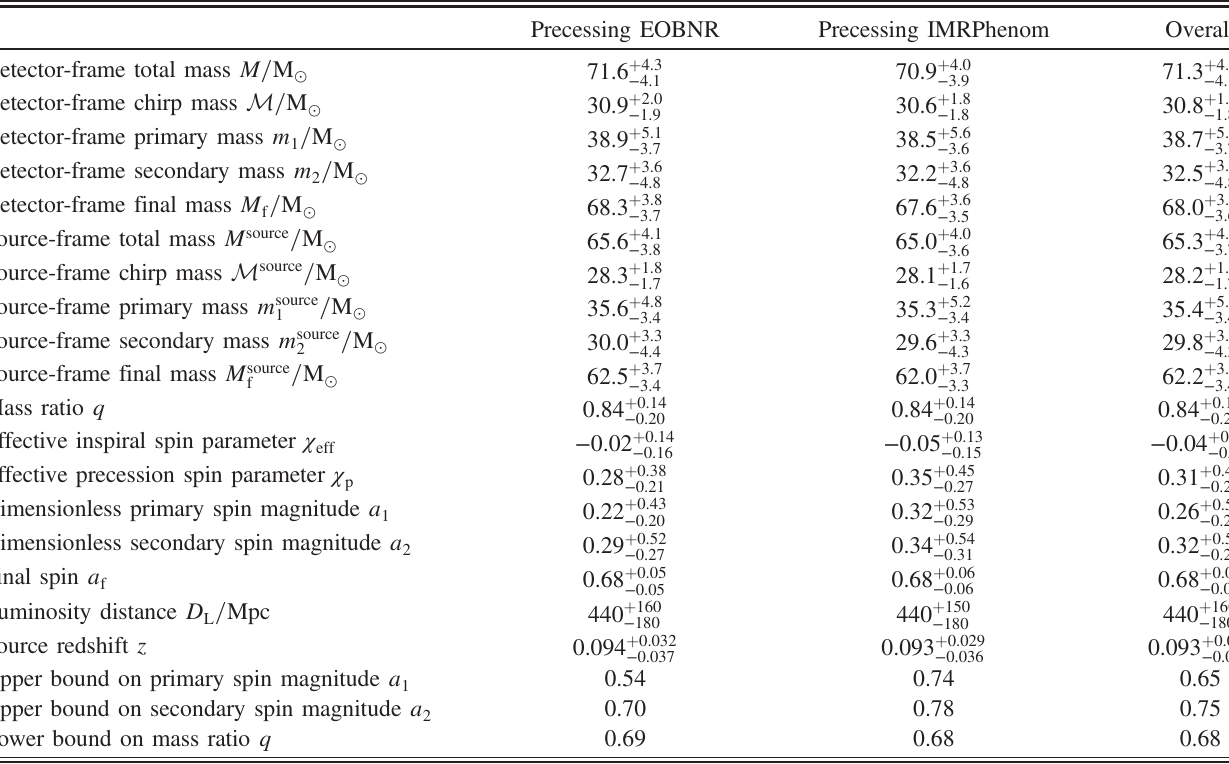
TABLE I. Median values of source parameters of GW150914 as estimated with the two precessing waveform models and with an equal-weight average of posteriors (in the “ Overall ” column). The models are described in the text. Subscripts and superscripts indicate the range of the symmetric 90% credible intervals. When useful, we quote 90% credible